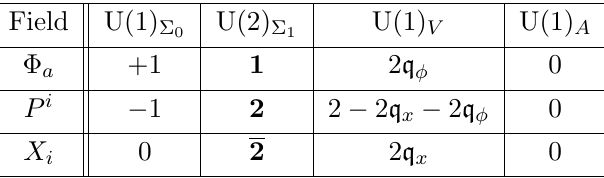
Table 2 . The U(1) (cid:6)